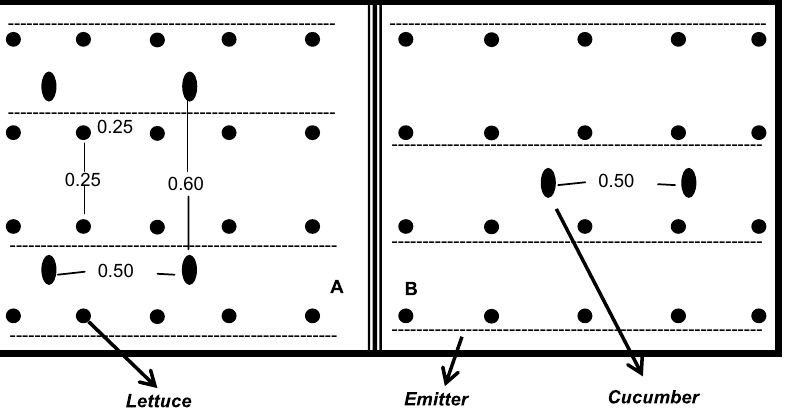
Fig. 1 – Graph of the plots with lettuce and cucumber in two plant population intercropping systems: A – lettuce (0.25 × 0.25 m) and cucumber with two rows on the bed (0.60 × 0.50 m) and B – lettuce and cucumber with one row on the bed (0.50 m between plants in the